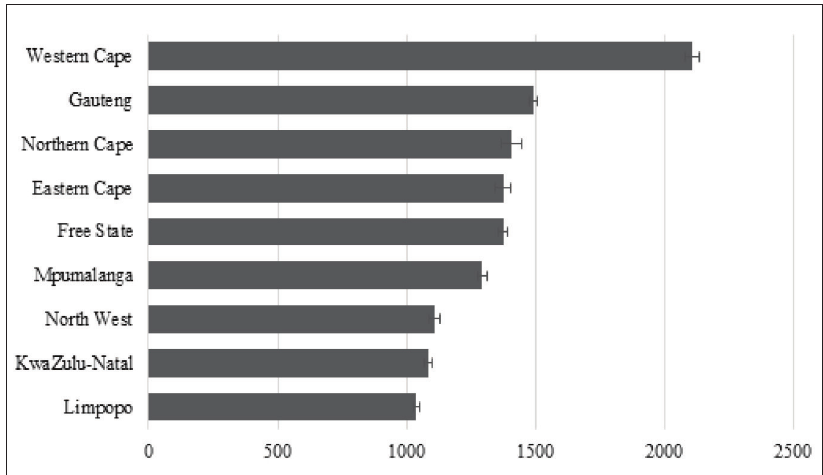
Figure 8: Average monthly salary per province (in Rand) (Source: Economic Policy Research Institute